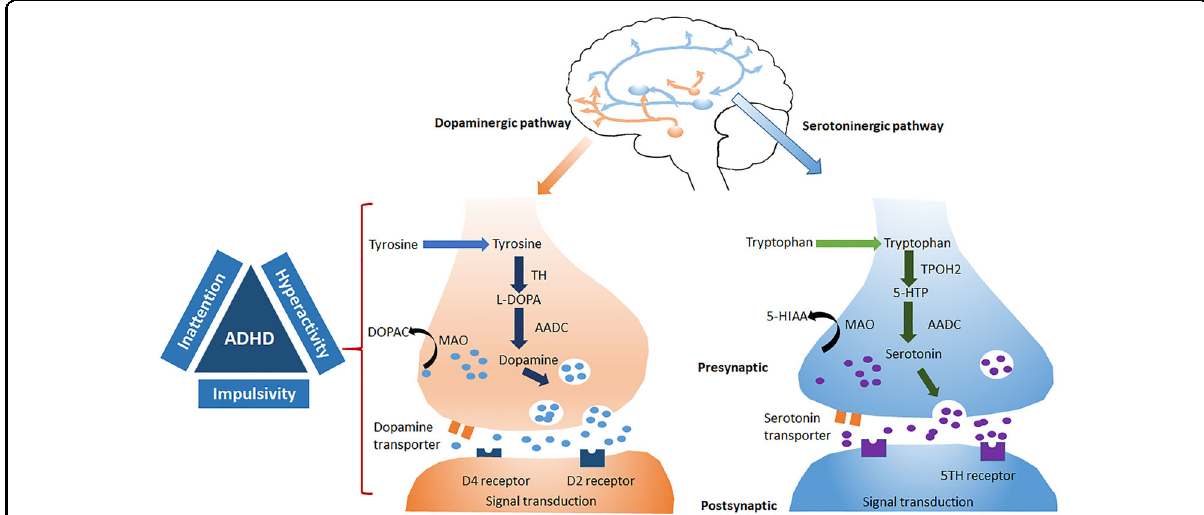
Fig. 3 Major pathways related to the pathogenesis of attention-de fi cit hyperactivity disorder (dopaminergic and serotonergic). Dopaminergic and serotonergic neurons are primarily located respectively in the midbrain and hindbrain and control various functions. Anomalies in dopamine and/or serotonin levels contribute to the symptoms of inattention, hyperactivity, and impulsiveness in attention-de fi cit hyperactivity disorder (Figure inspired from the manuscript by Fontana BD et al., 2019 187